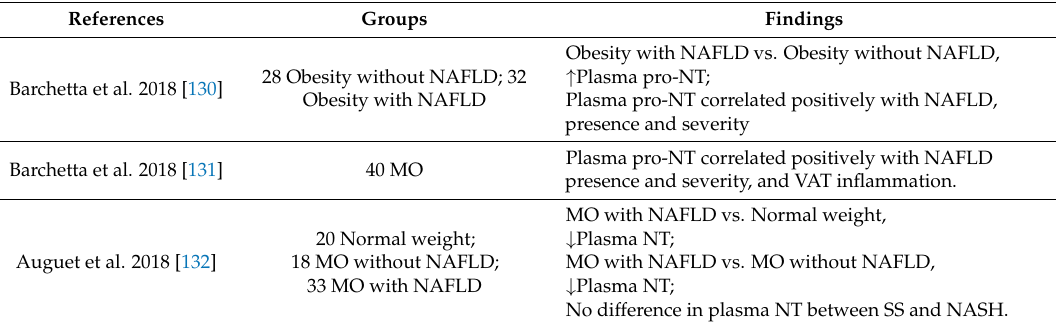
Table 2. Summary of relationships between the circulating NT/pro-NT levels in patients with